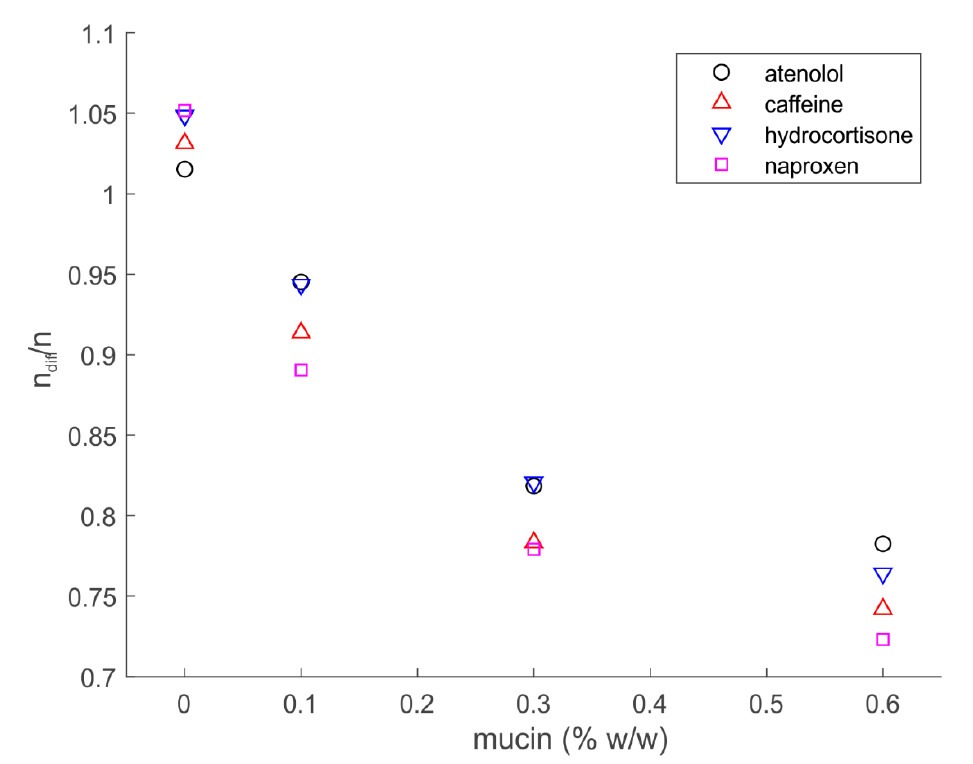
Figure 4. Ratio of drug amount observed (n dif ) and injected nominal amount (n i ) as function of mucin concentration. Table 3. Percentage reduction in diffusivities (D) with increasing mucin concentrations (0.1 – 0.6% MUC) compared to the absence of mucin for ATN, CAF, HYD, NPR, and MUC.